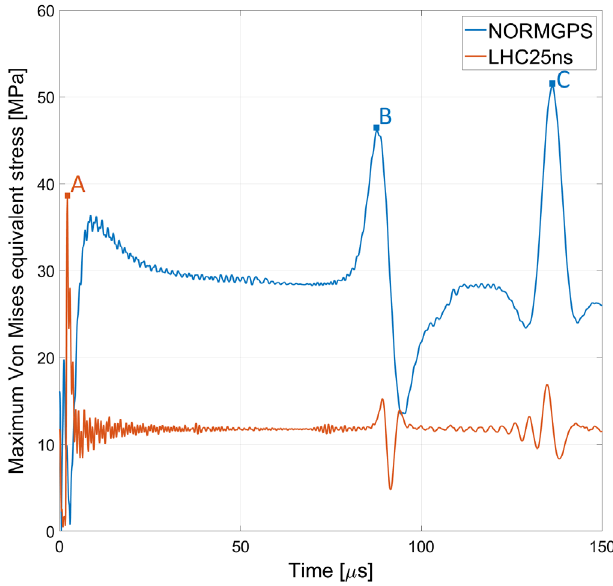
FIG. 13. Evolution over time of the maximum Von Mises stress in the dump core after impacts from the NORMGPS and LHC25 ns